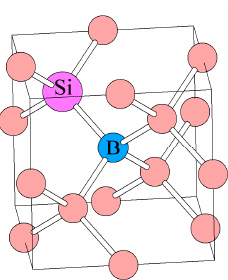
Table 6. Experimental and calculated g -, D -, and A -tensors for the GeV 0 ( S = 1) paramagnetic center [63].